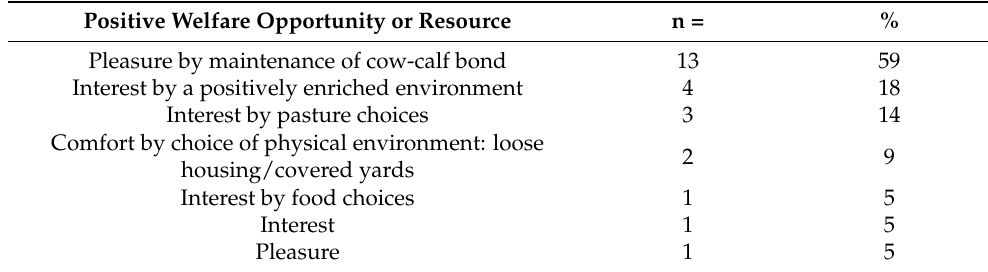
Table 3. Positive welfare opportunity or resource reported not to be valued by farmers (n =